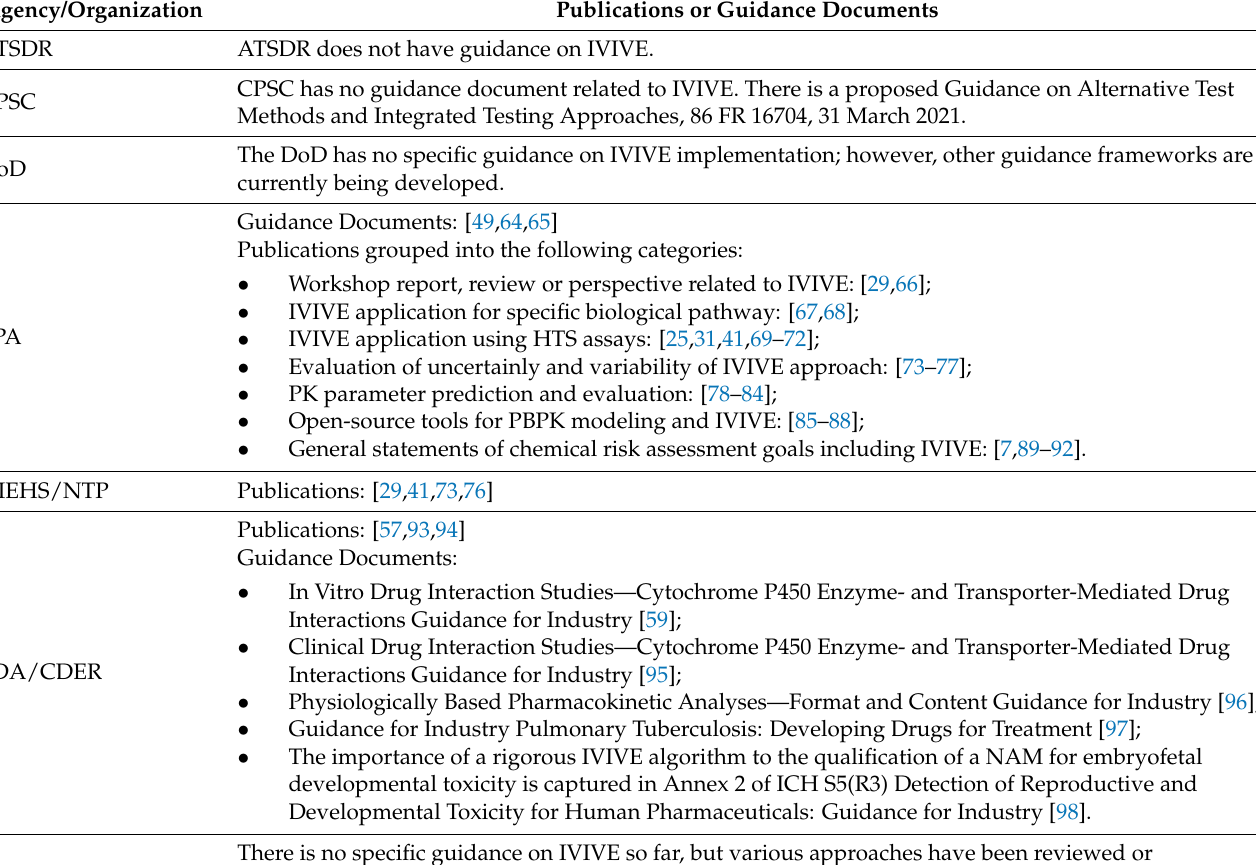
Table 2. Summary of current Agency’s publications or guidance documents that are related to IVIVE. Agency/Organization Publications or Guidance